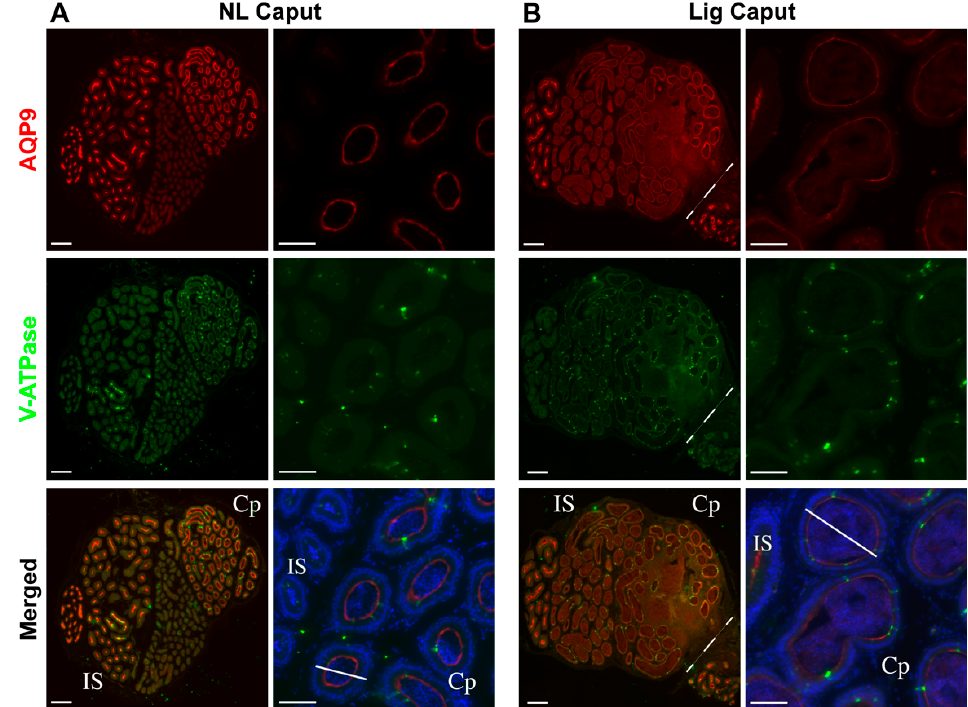
Figure 3. Expression of epididymal cell type markers after ligation. Confocal microscopy of tissue sections from the NL Caput and Lig Caput regions at 7-days post-ligation surgery. ( A ) NL Caput tissue sections were co-stained with AQP9 (red) to mark principal cells (upper panel), V-ATPase (green) to mark clear cells (middle panel), and DAPI (blue, merged with AQP9 and V-ATPase, lower panel). Scale bars: 100 µm (main images, left); 50 µm (magnifications, right). n = 3. ( B ) Lig Caput tissue sections were co-stained with AQP9 (red) to mark principal cells (upper panel), V-ATPase (green) to mark clear cells (middle panel), and DAPI (blue, merged with AQP9 and V-ATPase, lower panel). Scale bars: 100 µm (main images, left); 50 µm (magnifications, right). n = 3. The ligation suture region is indicated by a dotted line in the Lig Caput sections. Localization of specific epididymal regions were identified: initial segment (IS) and caput (Cp). White lines across the tubules are representative of the tubule diameter measurements.